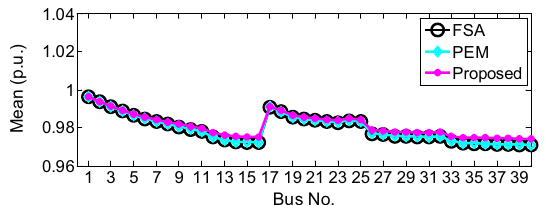
Fig. 11 Mean value of the PQ bus voltages